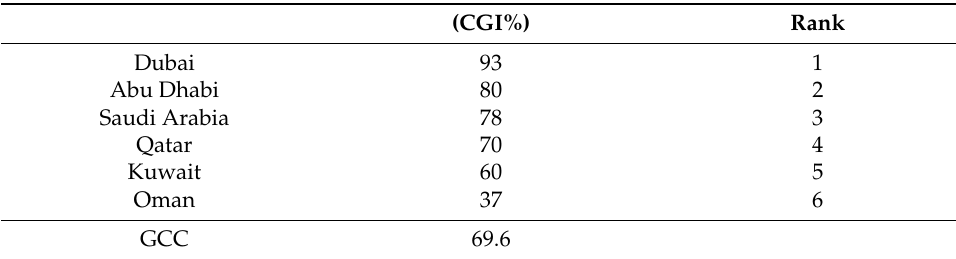
Table 3. CGI score country wise and for GCC.